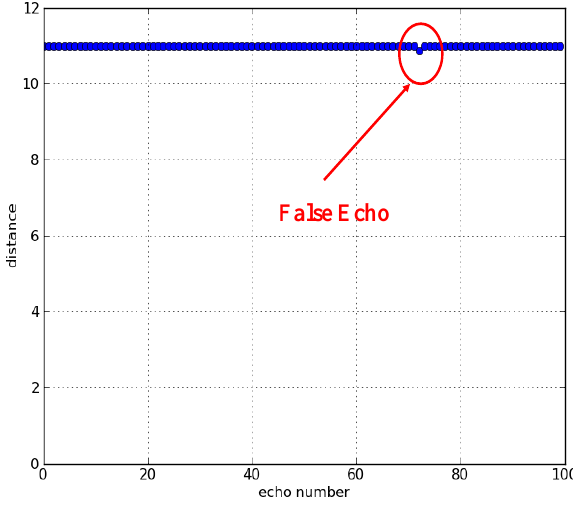
Figure 5. Measurements made with the sensor at rest and no obstacles ahead.